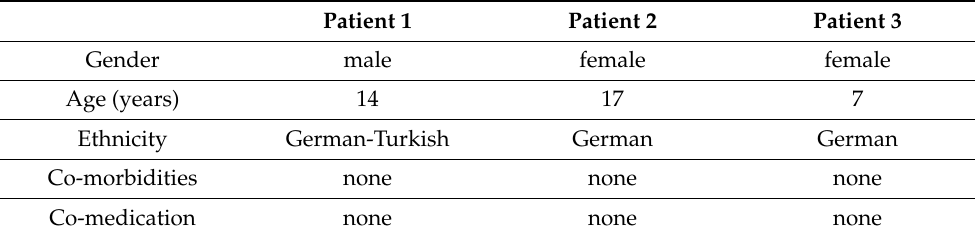
Table 6. Patient